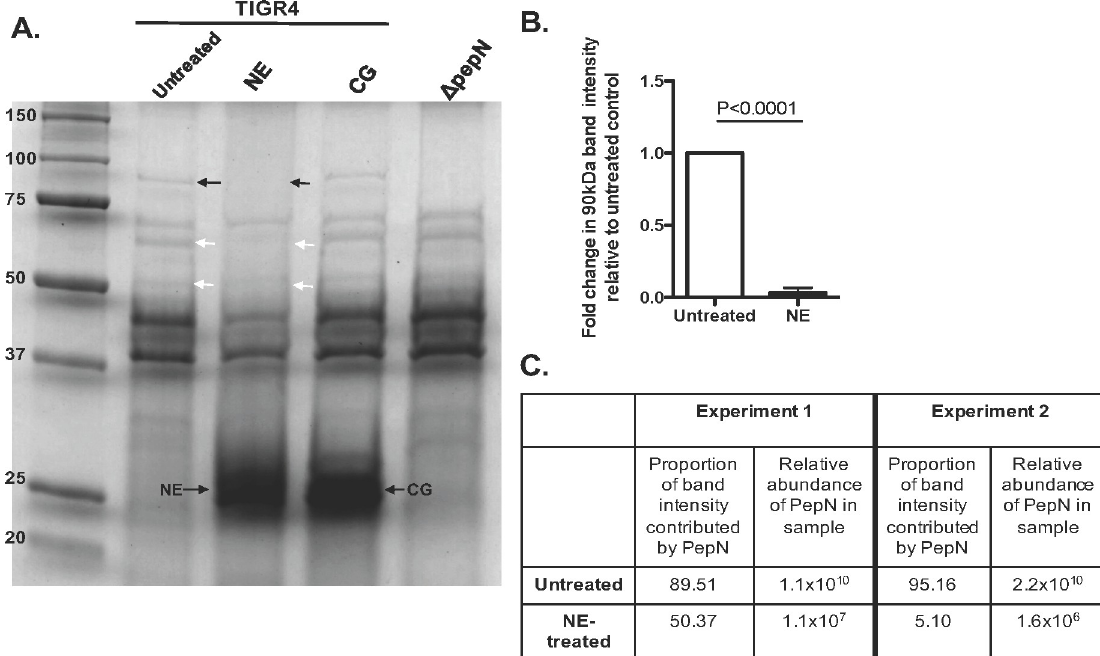
Fig 2. Neutrophil elastase degrades a 90kDa Spn CW protein in vitro . CW was isolated from TIGR4 and Δ pepN cells of S . pneumoniae and were left untreated or incubated with 68 μ M NE or 10 μ M CG. (A) Samples were analyzed using an AnykD gradient Tris-glycine polyacrylamide gel followed by colloidal Coomassie blue staining. Arrow heads indicate bands degraded by NE. Black arrow heads highlight the 90kDa species degraded by NE. (B) The intensity of the 90 kDa band in the untreated control or in CW samples treated with NE was quantified using ImageStudioLite. The data are presented as relative band intensity normalized to a blank lane. Data shown are means ± SD from 5 independent experiments. P = 0.019 using a Student’s t-test. (C) To determine the identity of the 90kDa protein that is degraded by NE, we excised this band from both the untreated and NE-treated lanes and had it analyzed via mass spectrometry. Additionally, this analysis quantified the relative abundance of the 90kDa protein in both the untreated and NE-treated samples. The gel is from one experiment representative of 5 independent experiments. The mass spectrometry analysis is from 2 of those independent experiments. NE, neutrophil elastase; CG, cathepsin G.